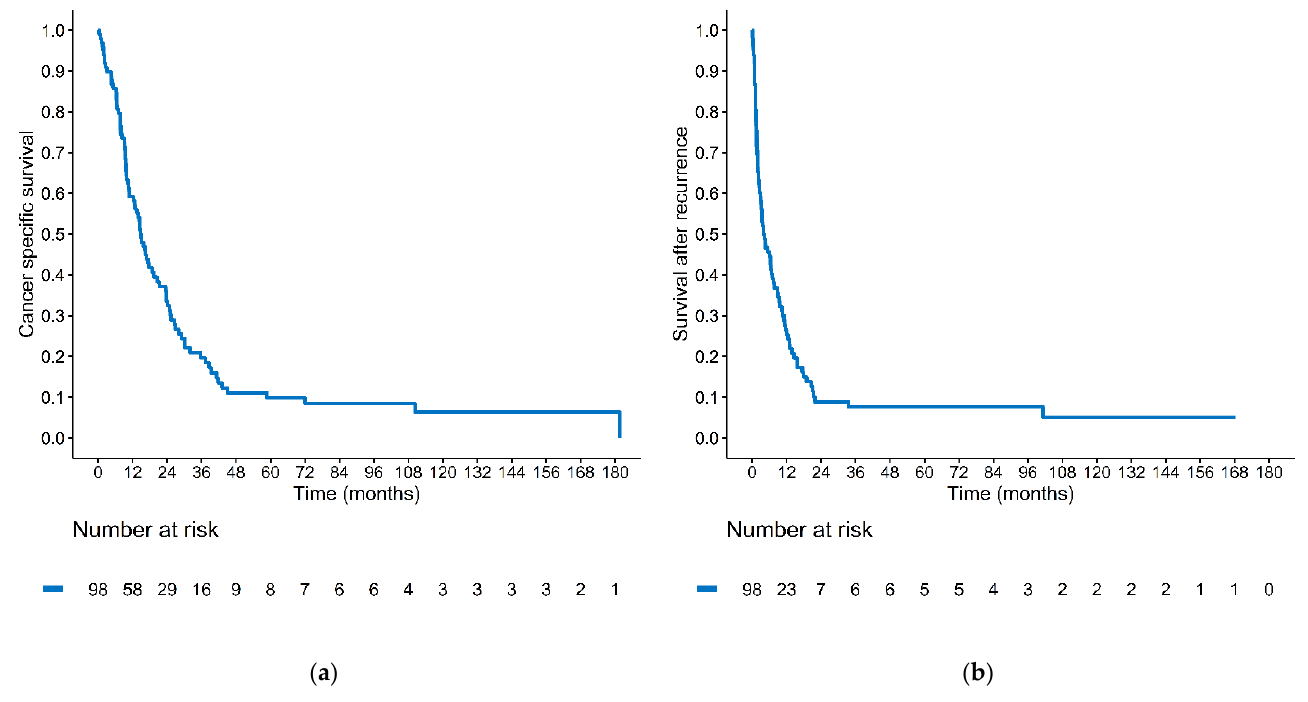
Figure 1. Kaplan–Meier estimates of ( a ) cancer-specific survival and ( b ) survival after recurrence in recurrent/progressive patients. ( N = 98). Table 1. Demographic characteristics of recurrent/persistent uterine carcinosarcoma patients.